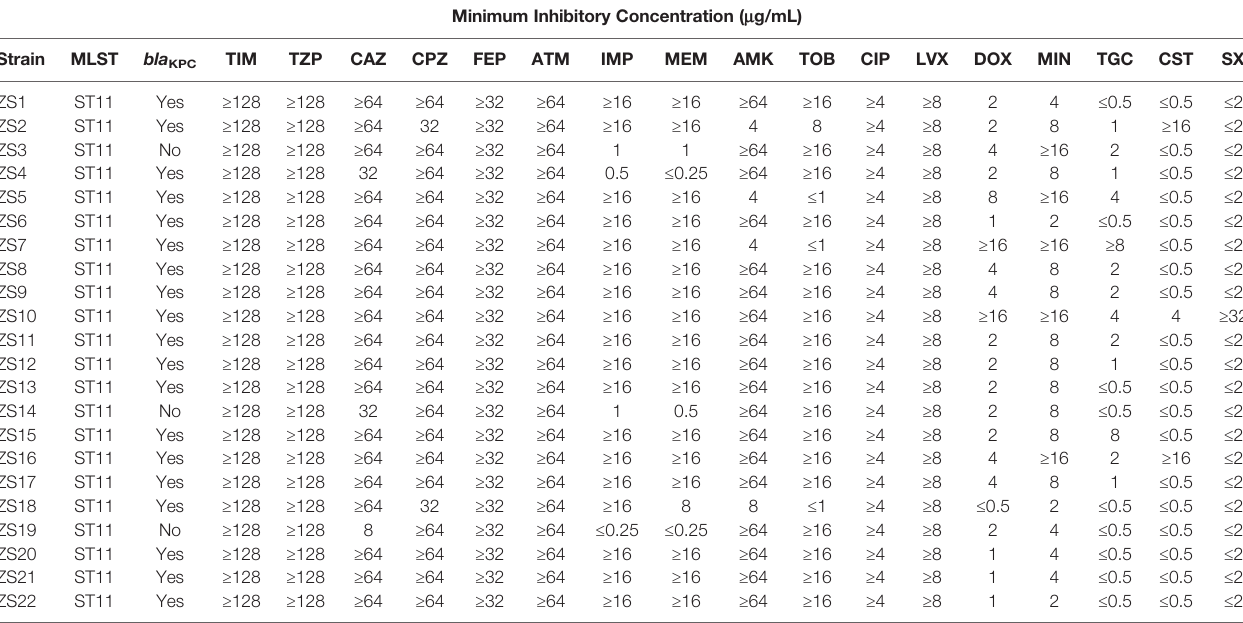
TABLE 1 | MLST types and antibiotic susceptibility pro fi les of the 22 K. pneumoniae